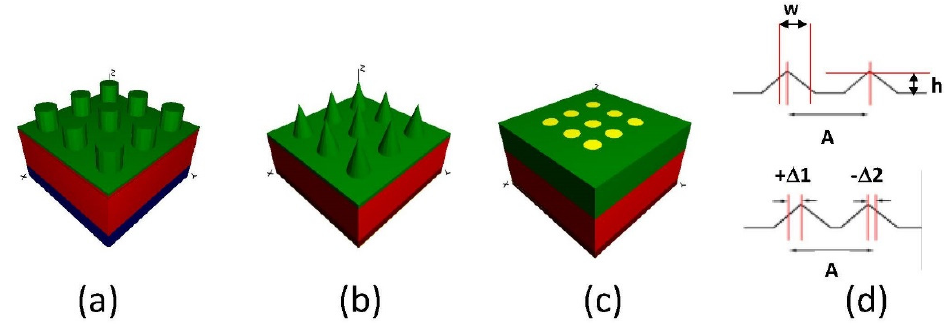
Figure 2. The schematic diagrams of the top grating simulation, ( a ) cylindrical pillar grating, ( b ) conical pillar grating, and ( c ) cylindrical nano-hole grating. ( d ) Error grating model: Normal reference grating model and error grating model with both positive and negative shifts.